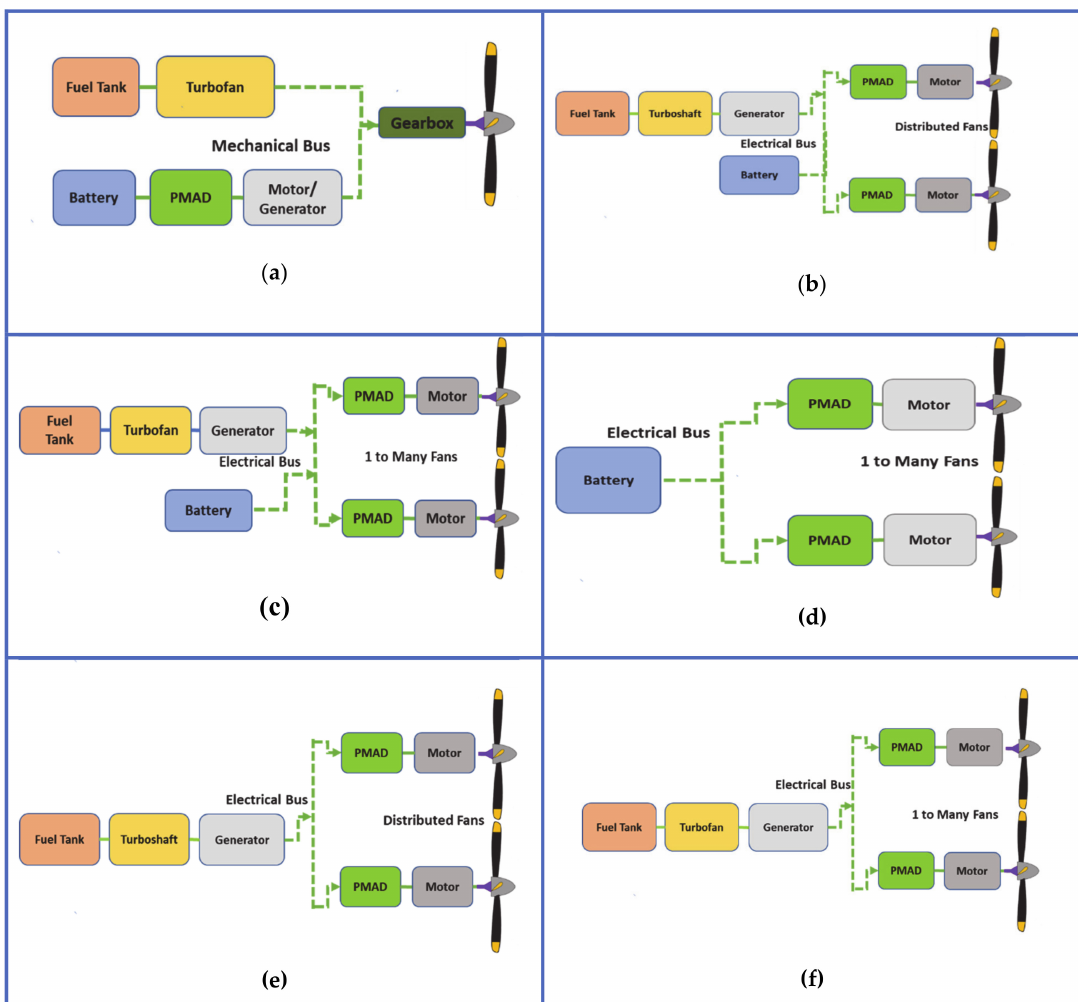
Figure 1. Illustration of various electric propulsion configurations adapted from Bowman et al. [12]. ( a ) parallel hybrid; ( b ) serial hybrid; ( c ) parallel / serial; ( d ) fully electric; ( e ) turboelectric; ( f ) partially